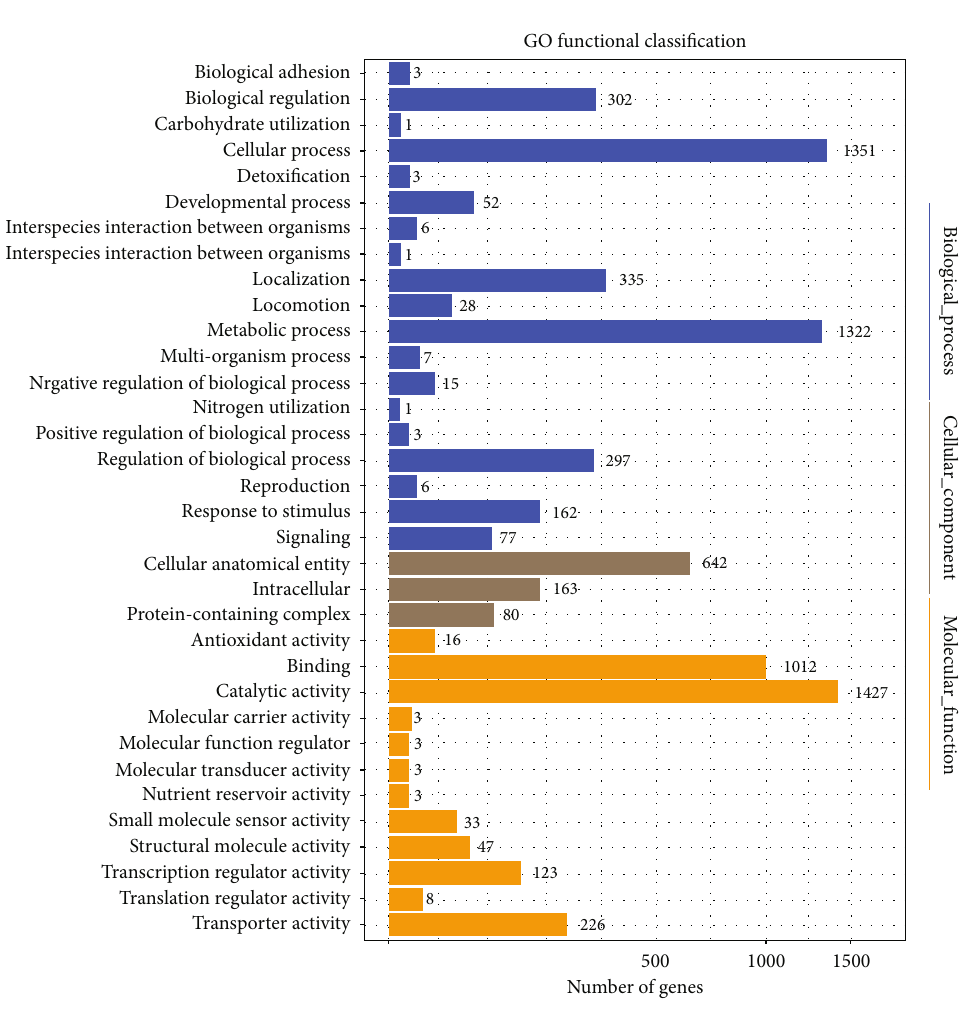
Figure 8: Annotation distribution map of GO functional